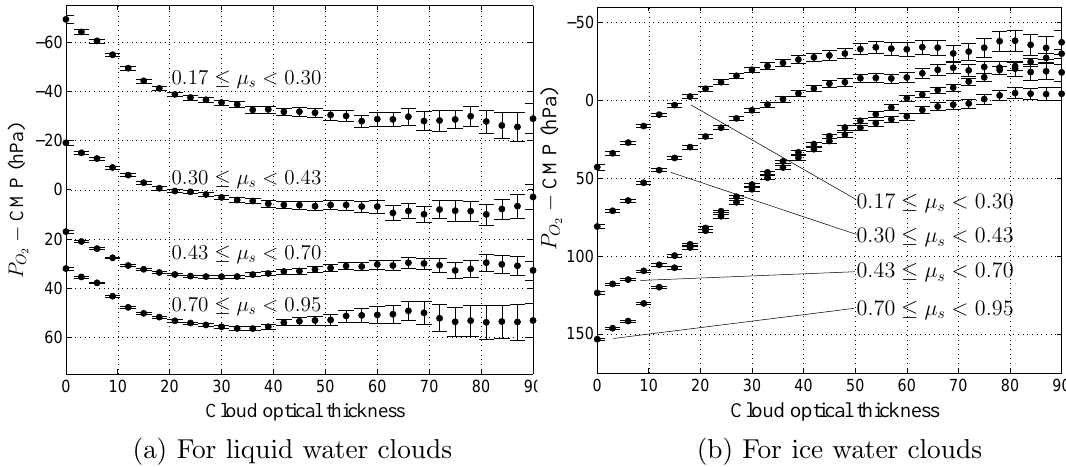
Fig. 5. Difference between POLDER oxygen pressure and actual cloud middle pressure (CMP) from CPR/CALIOP as a function of cloud optical thickness, on average in 2008 and by classes of solar zenith angle’s cosine. Standard deviations are indicated by error